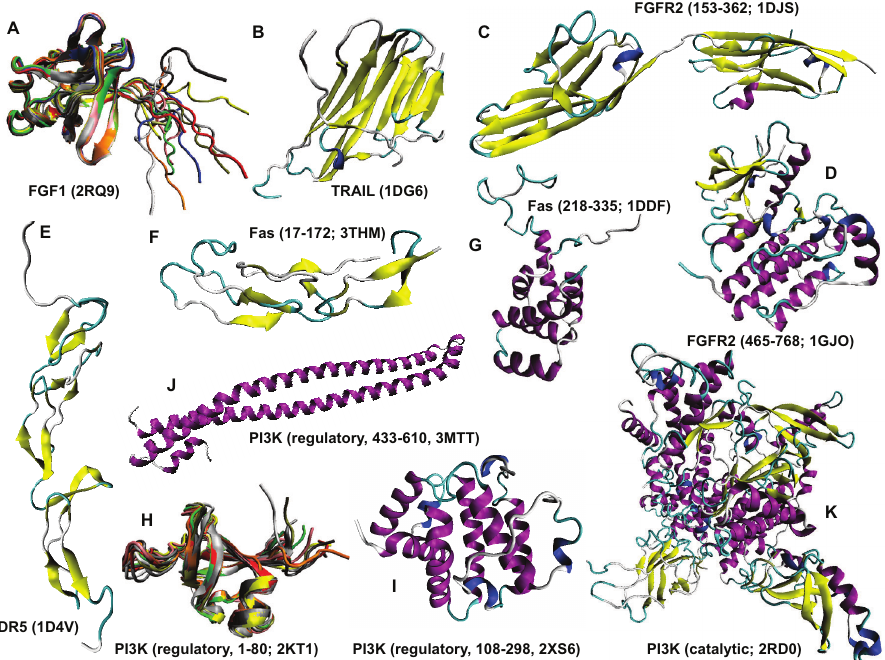
Figure 10. Structural characterization of human proteins involved in the p53-mediated apoptotic signaling pathways. A . Fibroblast growth factor 1 (PDB ID: 2RQ9); B . TRAIL (PDB ID: 1DG6); C . Fibroblast growth factor receptor 2 (residues 153–362; PDB ID: 1DJS); D . Fibroblast growth factor receptor 2 (residues 465–768; PDB ID: 1GJO); E . DR5 (PDB ID: 1D4V); F . FAS (Residues 17–172; PDB ID: 3THM); G . FAS (Residues 218–335; PDB ID: 1DDF); H . PI3K (regulatory subunit, 1–80; PDB ID: 2KT1); I . PI3K (regulatory 108–298; PDB ID: 2XS6); J . PI3K (regulatory subunit, 433–610; PDB ID: 3MTT); K . PI3K (catalytic subunit; PDB ID: 2RD0).